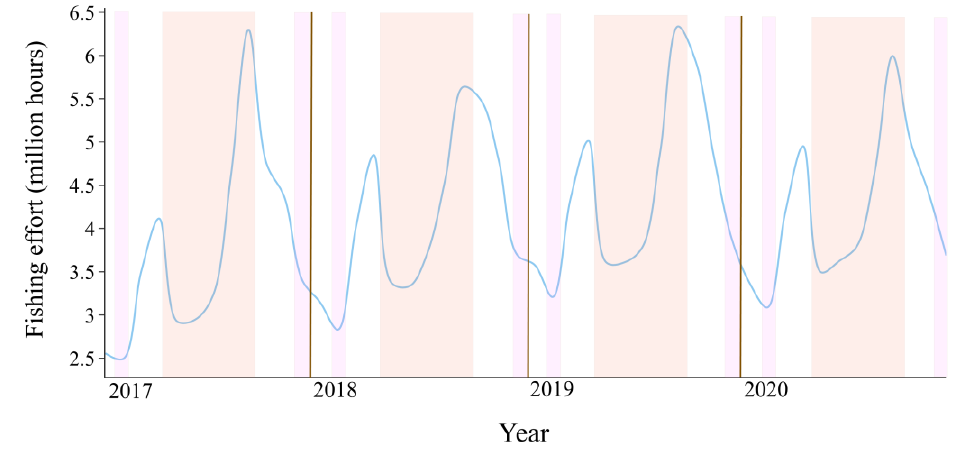
Figure 8. Global monthly fishing effort (millions of hours) from 2017 to 2020. The pink area is the cultural month of New Year and Christmas, and the orange area is China’s fishing closed season.